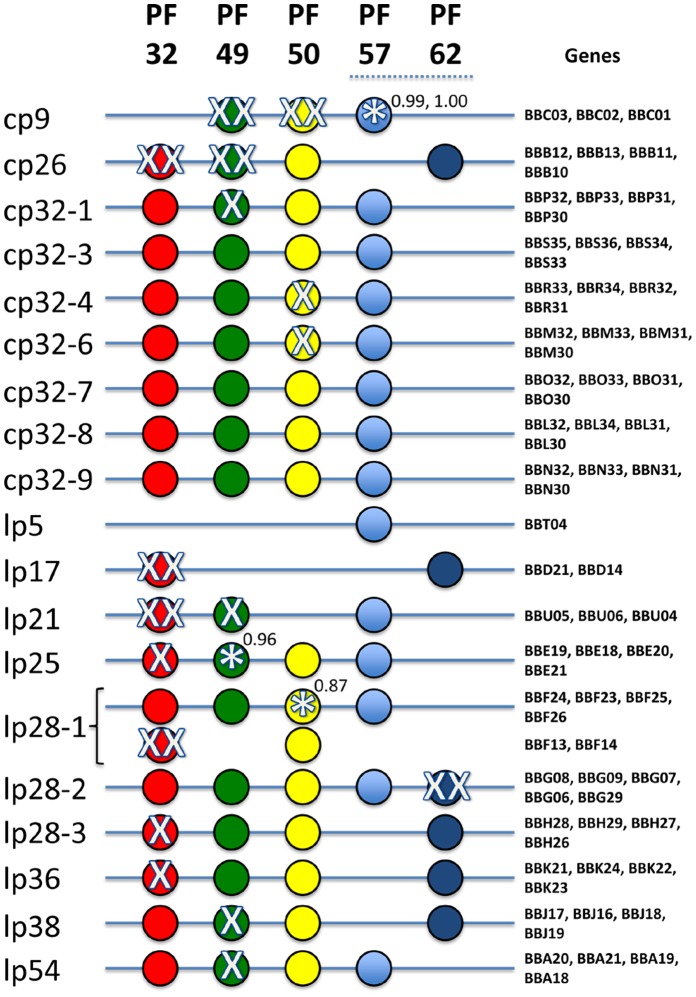
Transposon mutations in Protein Family (PF) genes postulated to be involved in plasmid maintenance.PF gene families are listed across the top. Presence of a full-length PF gene of each family is indicated by a colored circle. The plasmid and plasmid-associated PF genes are indicated on the left and right sides, respectively; the PF genes are listed in the same order (left to right) as in the figure. lp28-1 has two PF gene loci. Genes with multiple transposon insertions are marked as XX, whereas those with single mutations have a single X. Genes that have insertions only at the end of the gene are marked by an asterisk; the adjacent number indicates the insertion ratio.